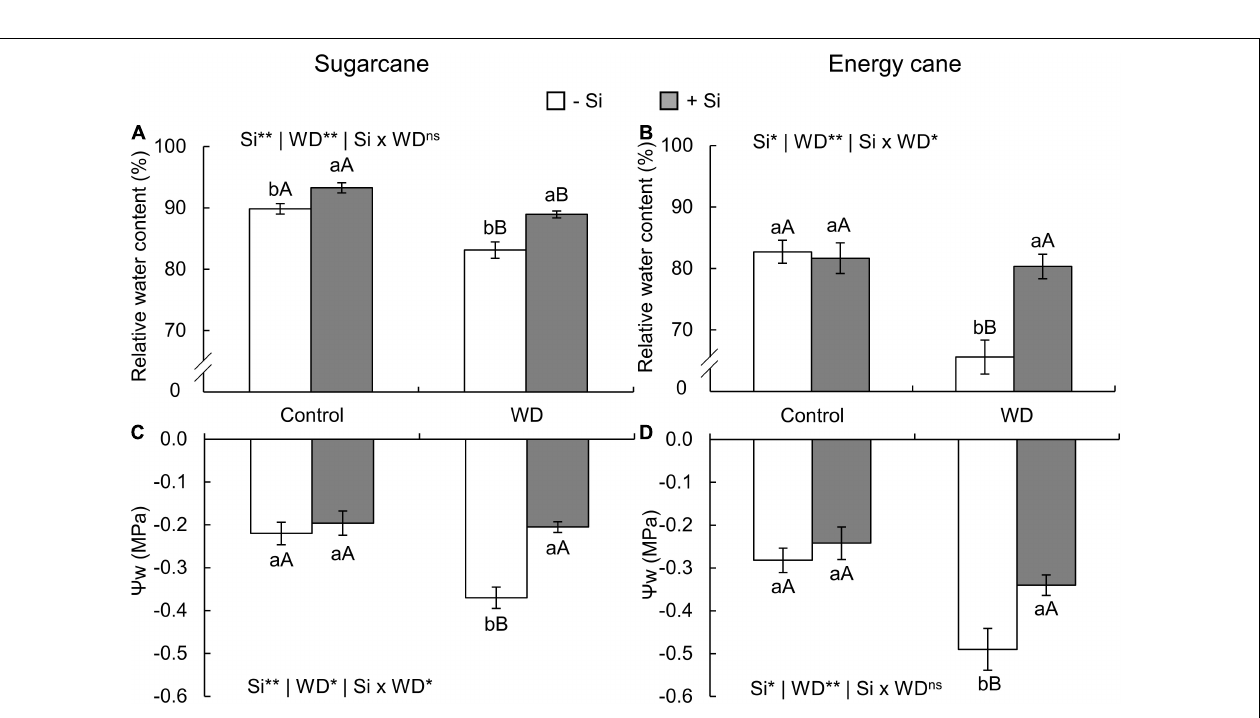
Frontiers in Plant Science |